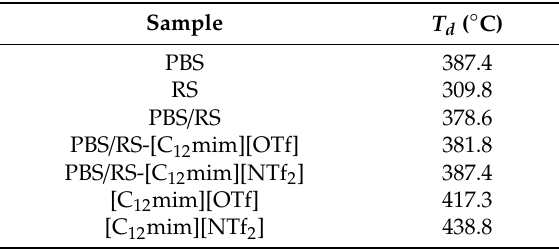
Figure 5. TGA thermograms of the PBS, RS and PBS/RS blends without and with containing ILbS. Table 6. T d of the PBS, RS and PBS / RS blends without and with containing ILbS as obtained from TGA